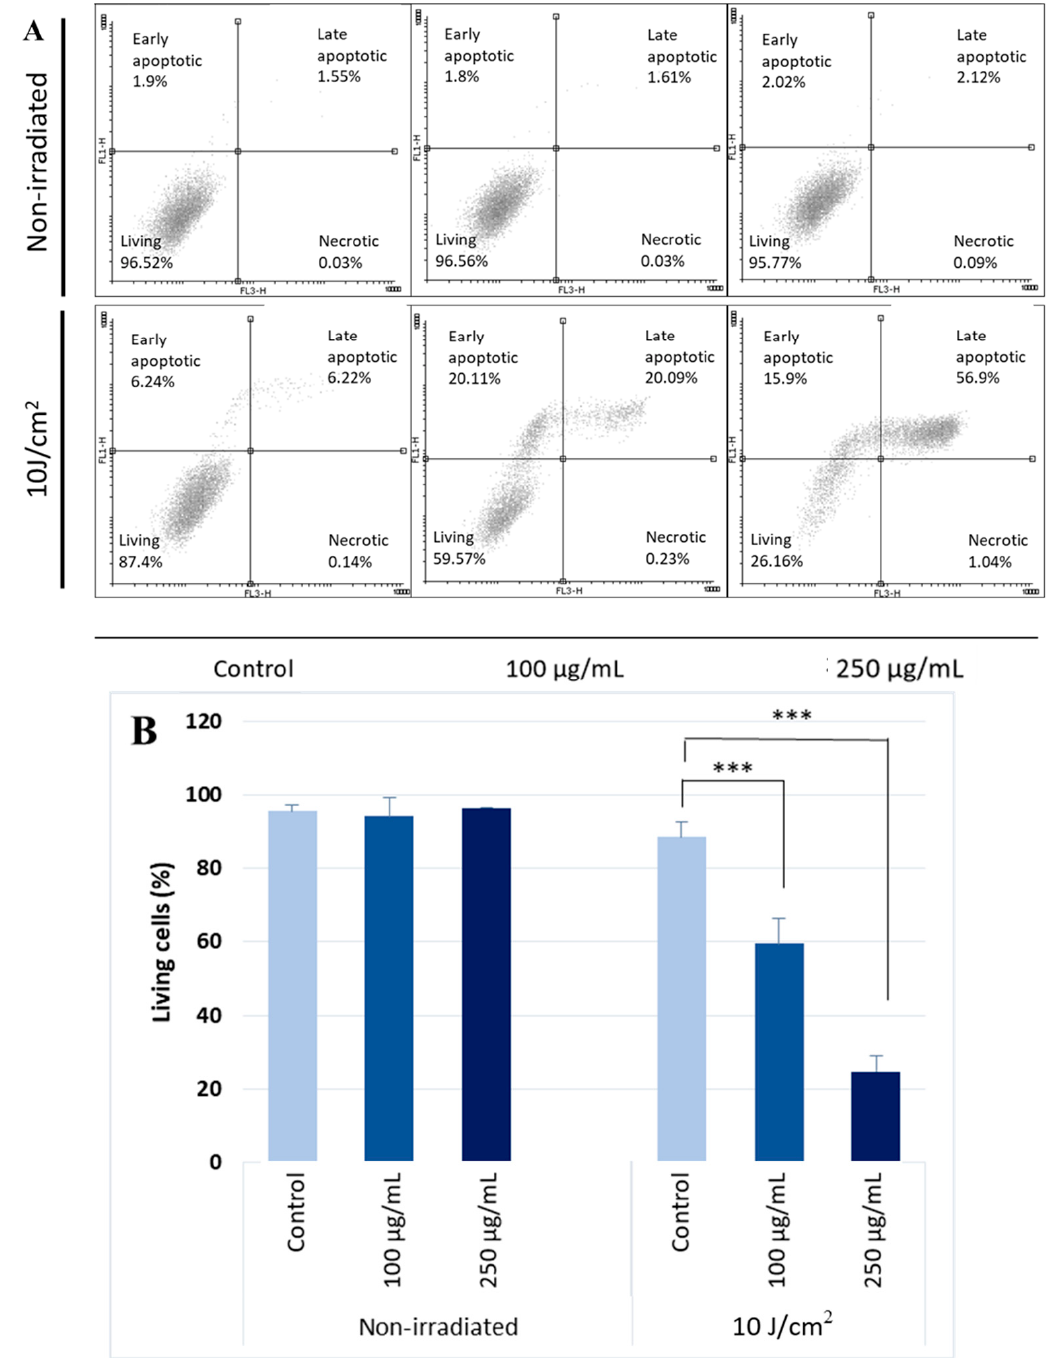
Figure 2. UVA photosensitizing effect of silymarin. ( A ) Effect of 10 J/cm 2 UVA radiation and silymarin + UVA co-treatment was measured by Annexin V and propidium iodide dual staining. ( B ) Live percentage as a mean of three independent experiments after silymarin treatment. Error bars represent SD; *** indicates statistically significant difference at p < 0.001.